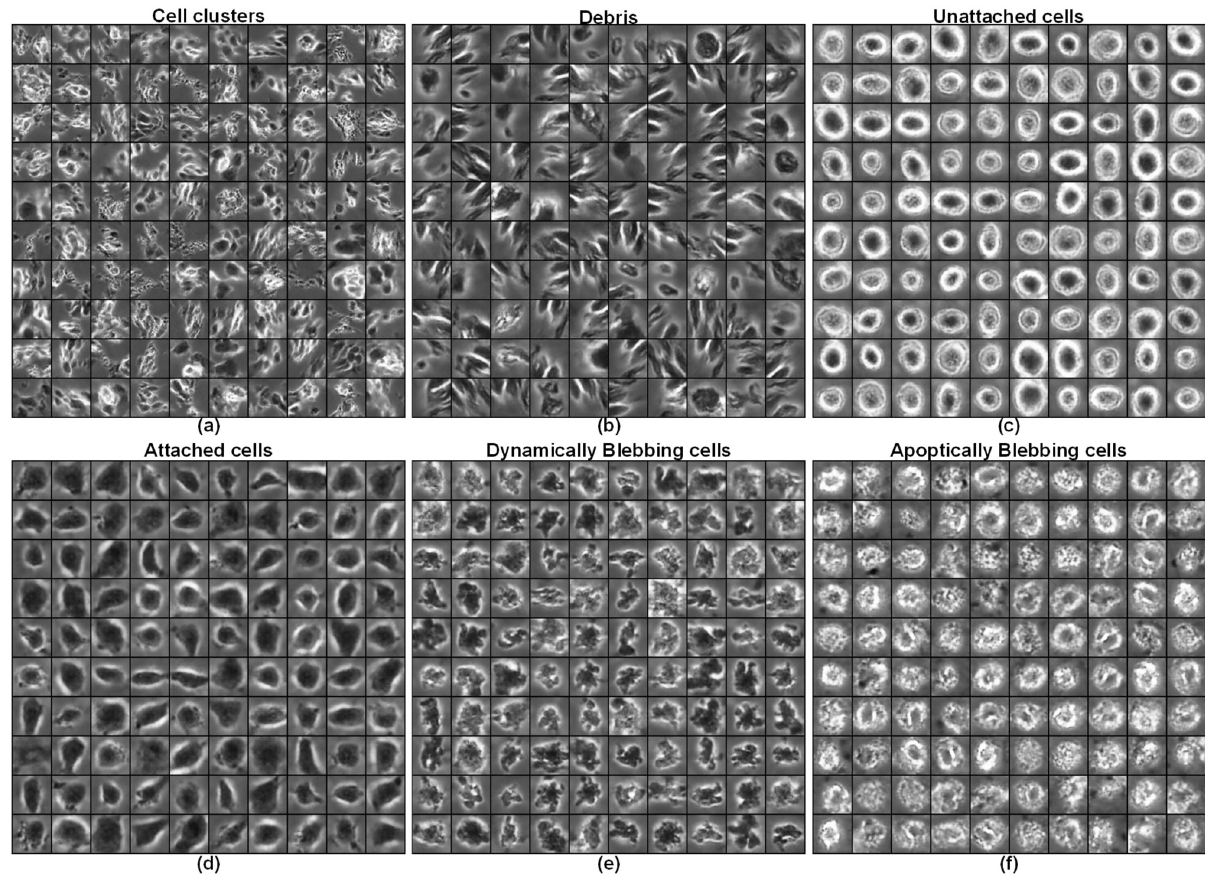
Fig 14. The 600 synthetic images used for validating the quality in Table 12. (a) Cell clusters , (b) Debris , (c) Unattached cells , (d) Attached cells , (e) Dynamically Blebbing cells , (f) Apoptically Blebbing cells